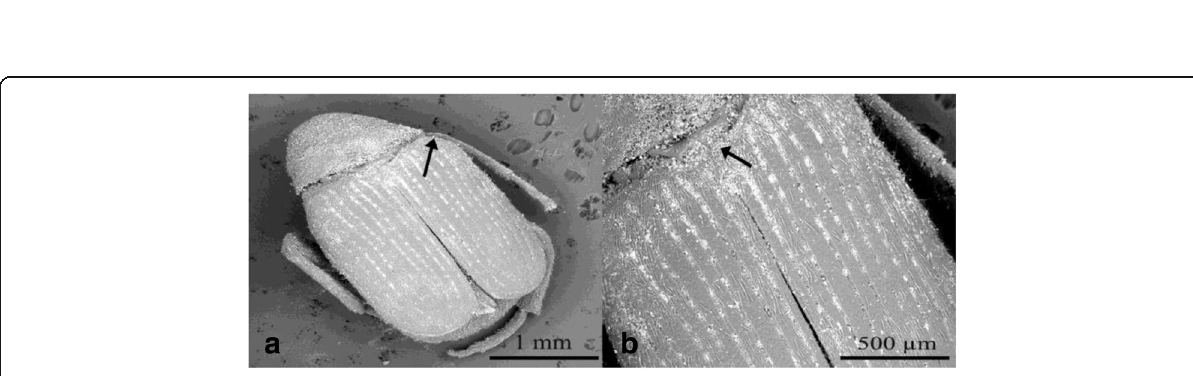
Fig. 5 Scanning electron microscope images of Callosobruchus maculatus adults exposed to 74.7 ppm of nano zeolite treated cowpea. a Dorsal view, particles of nano zeolite aggregate on insect surface and on leg joints (arrow). b Section of dorsal view particles of nano zeolite aggregate between thorax and abdomen joints (arrow)